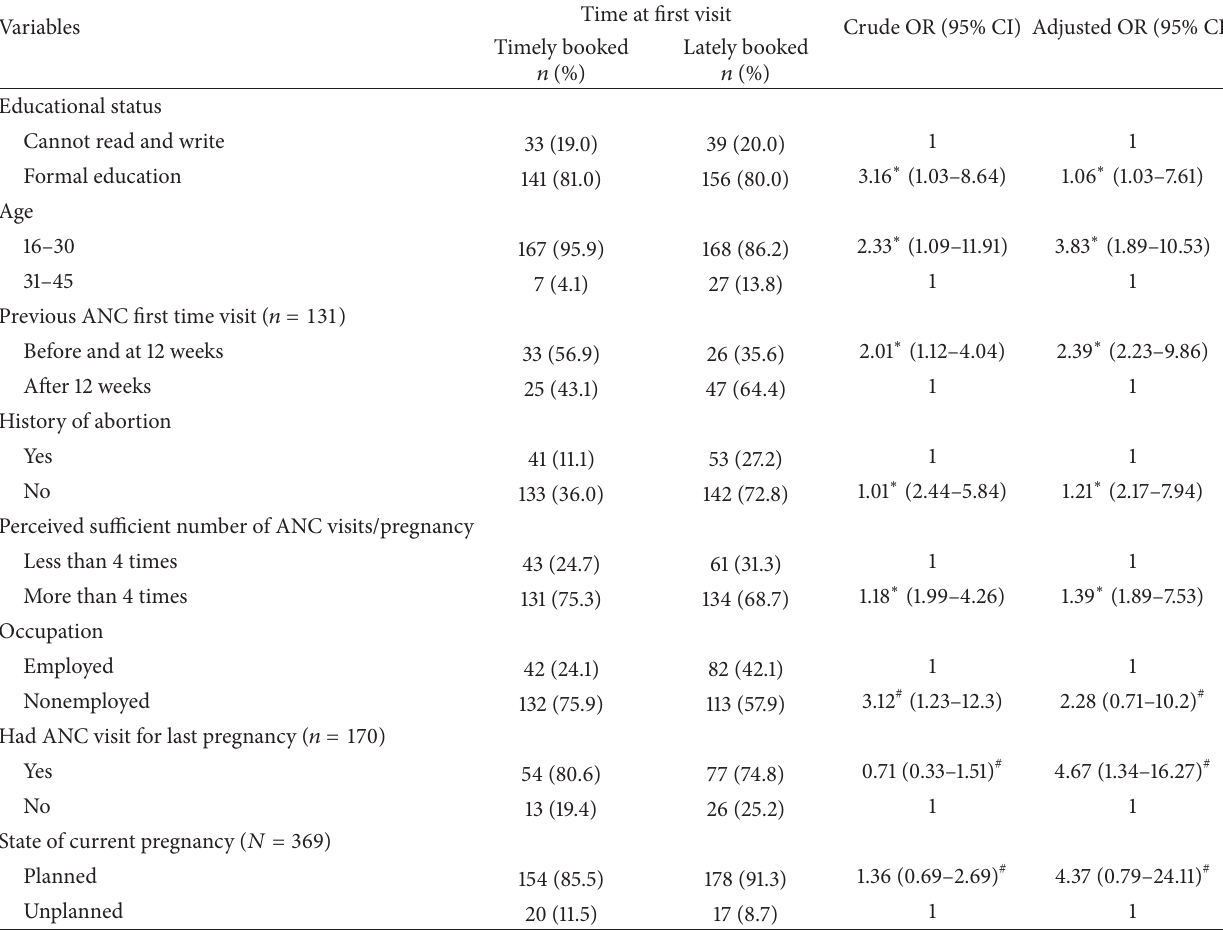
Table 3: Factors affecting booking of first ANC visit, University of Gondar Hospital, Northwest Ethiopia, 2013 ( 𝑁 = 369 ).